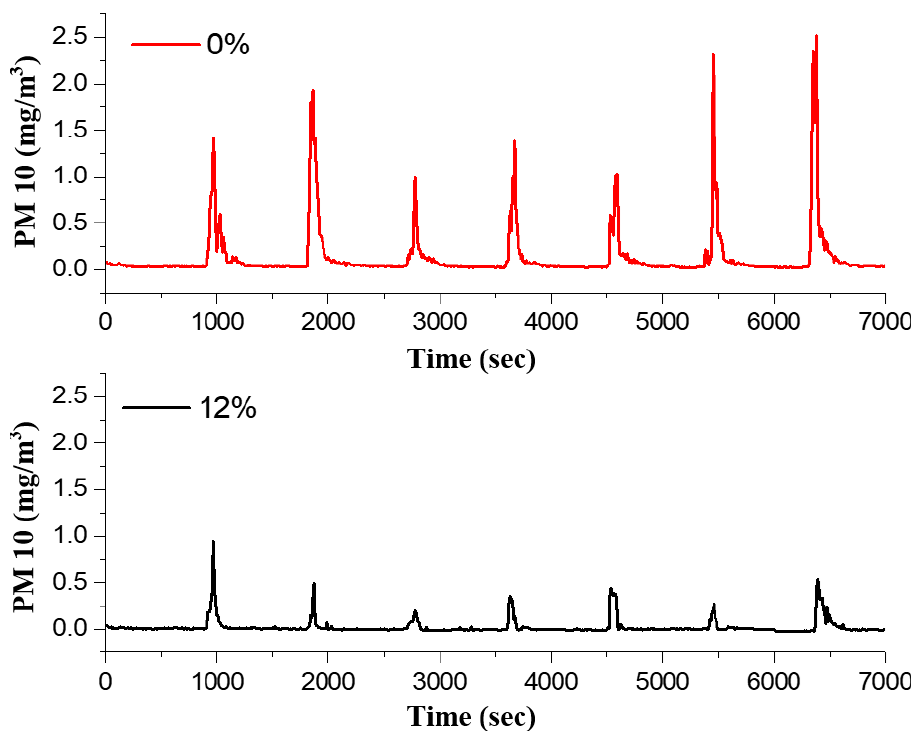
Figure 13. PM 2.5 dust generation due to human activity in soil samples coated with 0% and 12% coating solution.